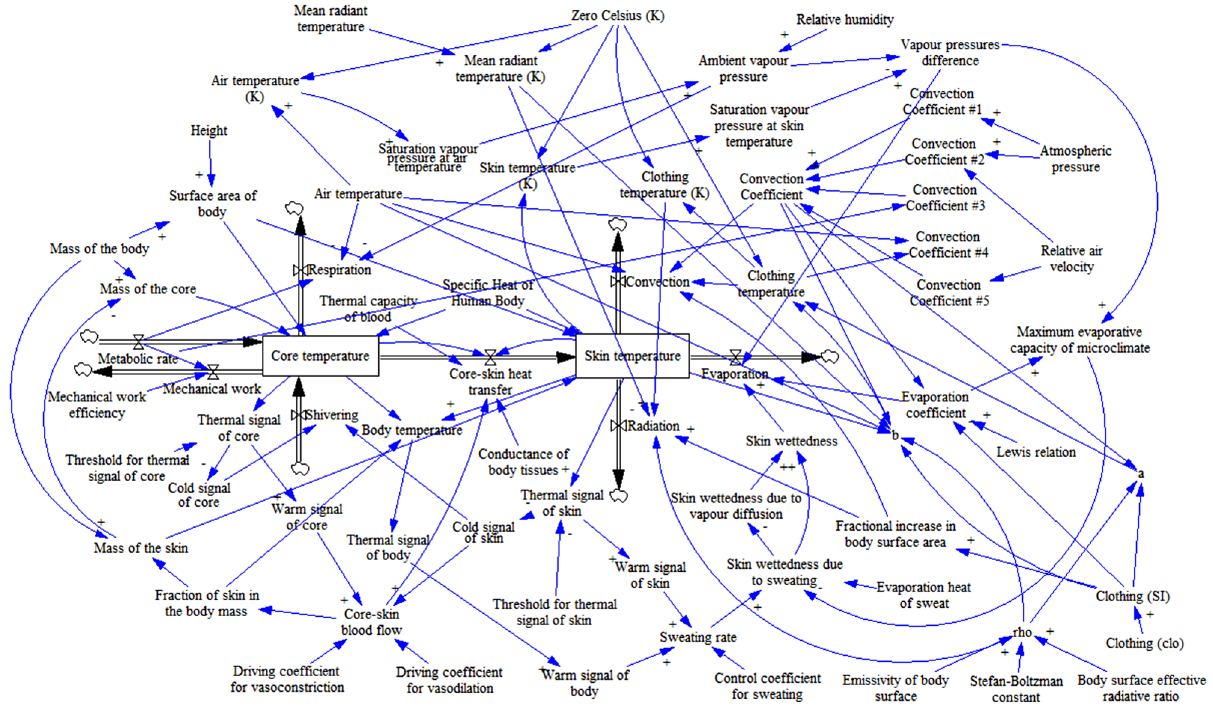
Figure 1. Stocks-and-flows diagram of system dynamics model of human body thermal regulation 50 . Energy stocks (core and skin components of the body) are enclosed in rectangles. Energy flows are represented with the arrows with “valves”, where arrow direction indicates a positive direction of energy flow, but does not restrict the flow only in this direction. Parameters are represented with text labels, and blue arrows indicate causal relations between them, with polarity signs indicating the change of dependent variable with an increase in the governing